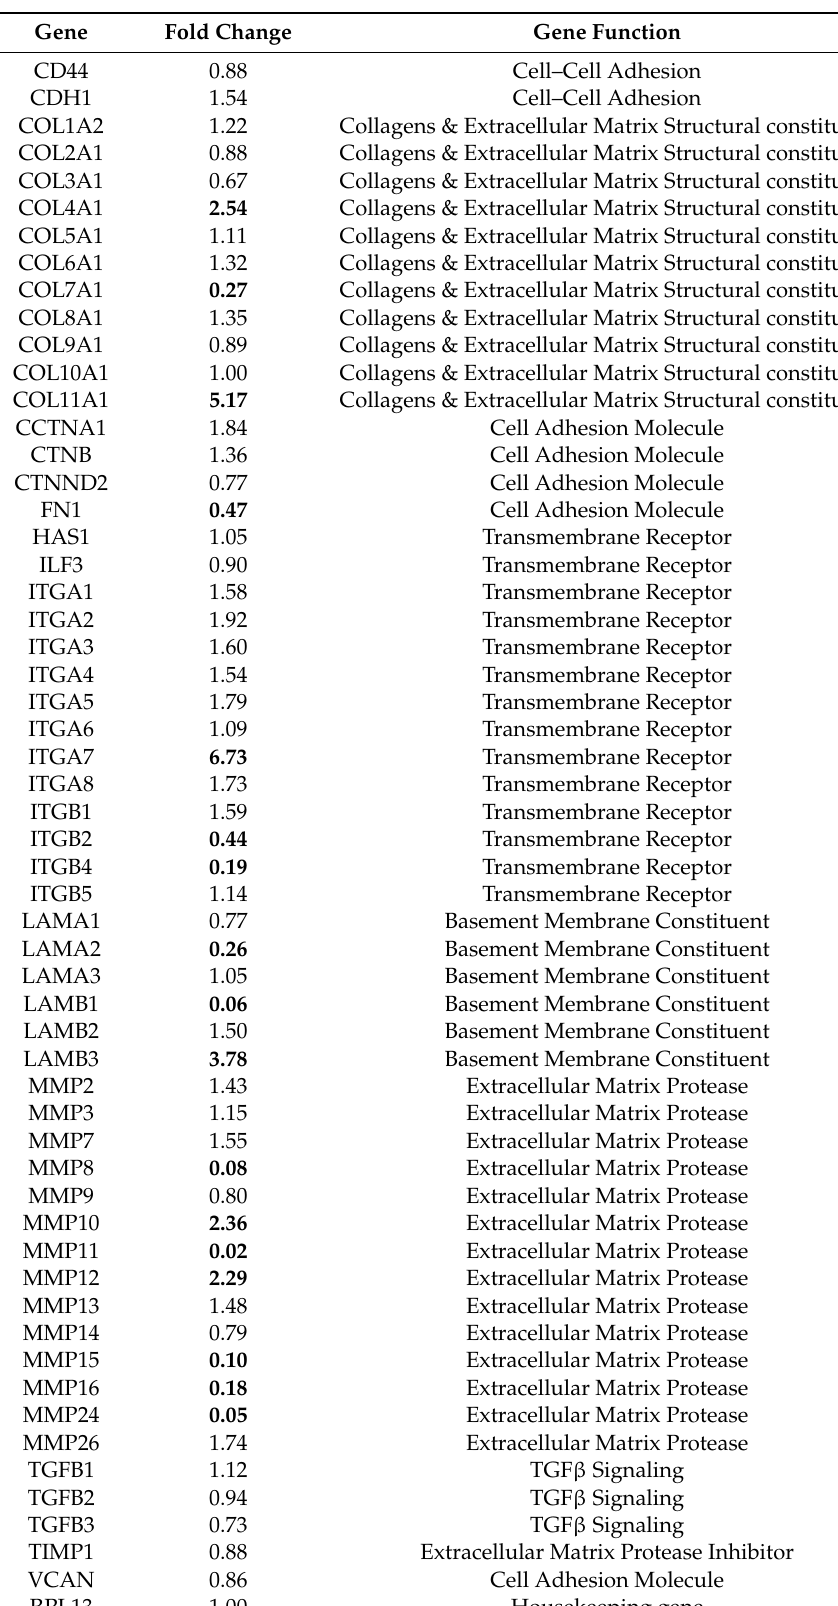
Table 1. Gene expression profile of 57 genes belonging to the “Extracellular Matrix and Adhesion Molecules” pathway analyzed using Real time PCR after 24 h of treatment with